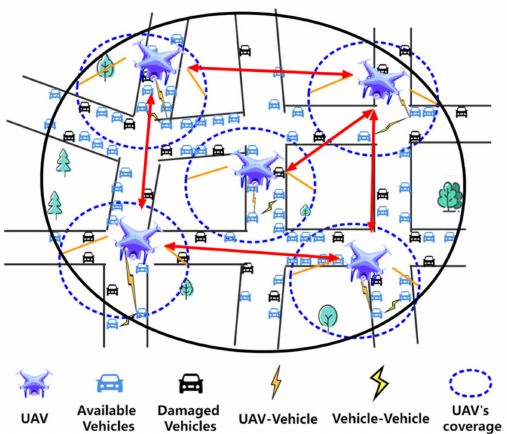
Figure 1. System model in post-disaster